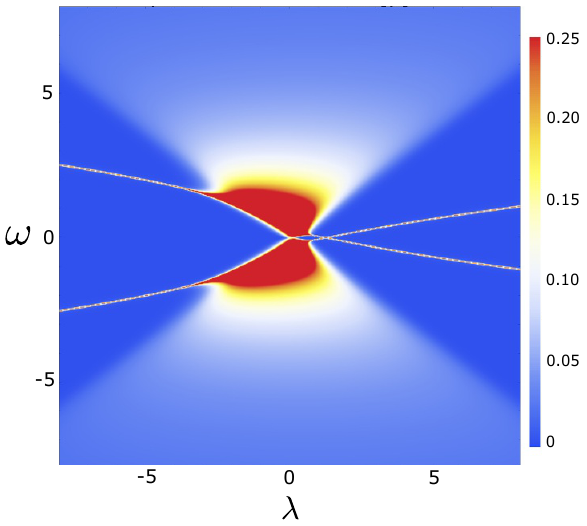
Figure 8 . The spectral function at g = 0 : 5 and zero momentum as a function of (cid:21) . Here, the quantum critical point is clearly visible for (cid:21) = 1 : 25, whereas there is no critical point for a negative value of (cid:21)